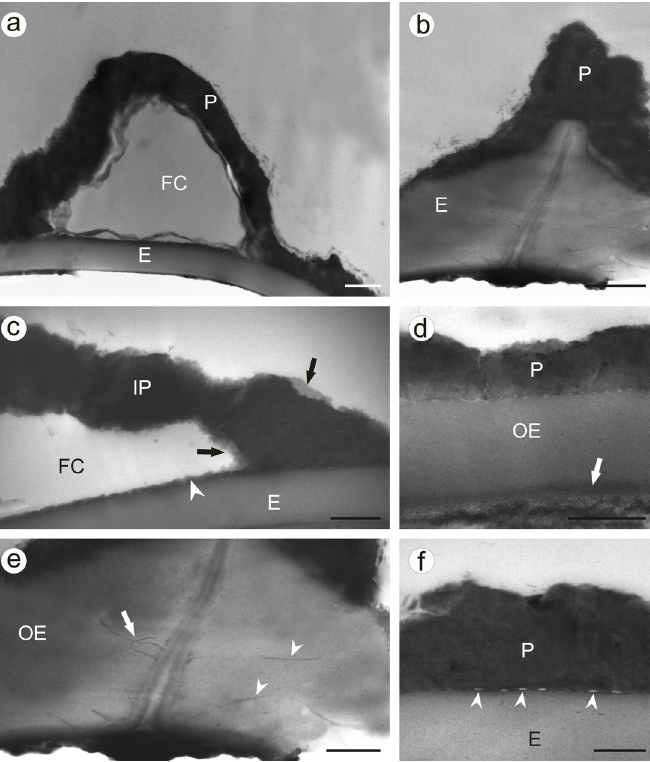
Figure 6. Spores of C. submarginalis with TEM. a. Section through the sporoderm. The smooth exospore (E) is observed and the perispore (P) forms the ornamentation. FC: fold cavity. b. Section through the laesura. The exospore (E) widens where the laesura emerges